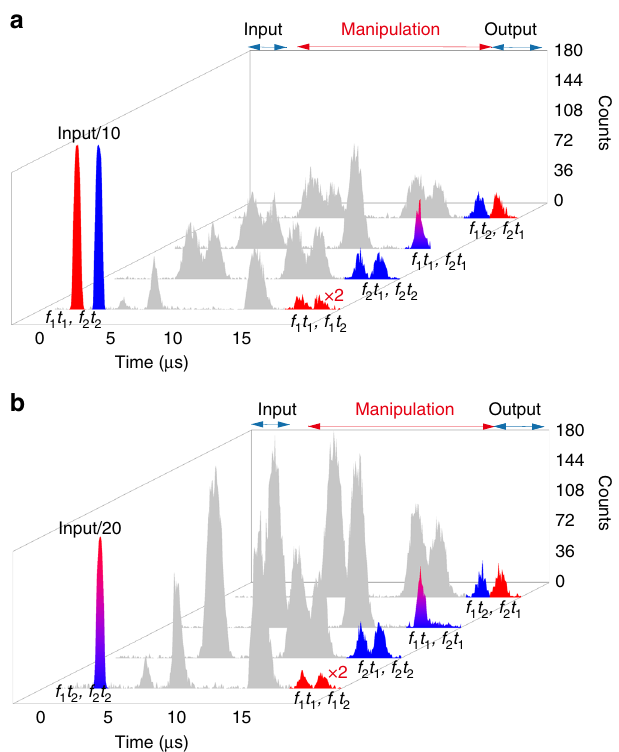
Fig. 5 Arbitrary temporal and spectral manipulations in real time. Four typical operations are presented for two different input states. a The OAM qutrit state | ψ 1 〉 is encoded on the f 1 t 1 and f 2 t 2 modes. The f 1 photons are marked as red color and the f 2 photons are marked as blue color. These operations, from up to down, correspond to a pulses sequencer, a multiplexer, a selective spectral shifter and a con fi gurable beam splitter (the f 2 photons are fi ltered out), respectively. The little “ ×2 ” indicates that the integration time of temporal beam splitting is two times of the other operations. b The OAM qutrit state | ψ 2 〉 is encoded on the f 1 t 2 and f 2 t 2 modes. These operations, from up to down, correspond to a demultiplexer, a pulses sequencer, a selective spectral shifter (the f 1 photons is frequency shifted to f 2 and retrieved at t 1 , while the f 2 photons are retrieved at t 2 ) and a con fi gurable beam splitter (the f 2 photons are fi ltered out), respectively. All of these operations can be determined after the photons have been absorbed into the quantum memory. The inputs are shifted earlier by 3 μ s